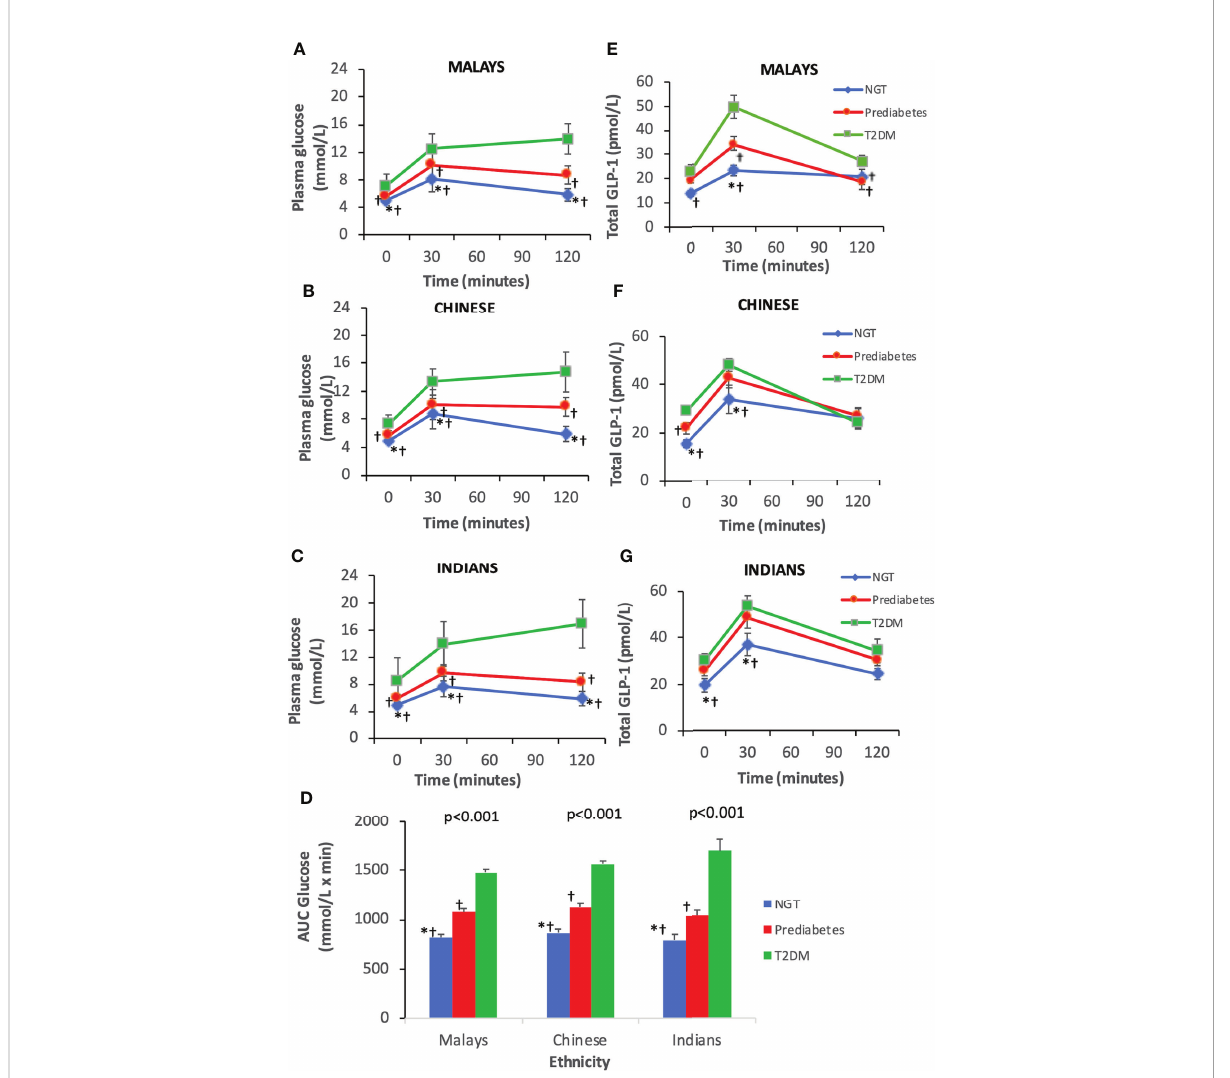
FIGURE 2 Time courses for plasma concentrations of glucose and glucagon-like peptide-1 (GLP-1) during an oral glucose tolerance test by ethnicity. Data are expressed as mean ± SD for (A – C) glucose levels, (D) AUC Glucose , and (E – G) total GLP-1 levels. *p < 0.05 versus pre-diabetes, ƚ p < 0.05 versus T2DM. AUC, area under the curve; NGT, normal glucose tolerance; T2DM, type 2 diabetes